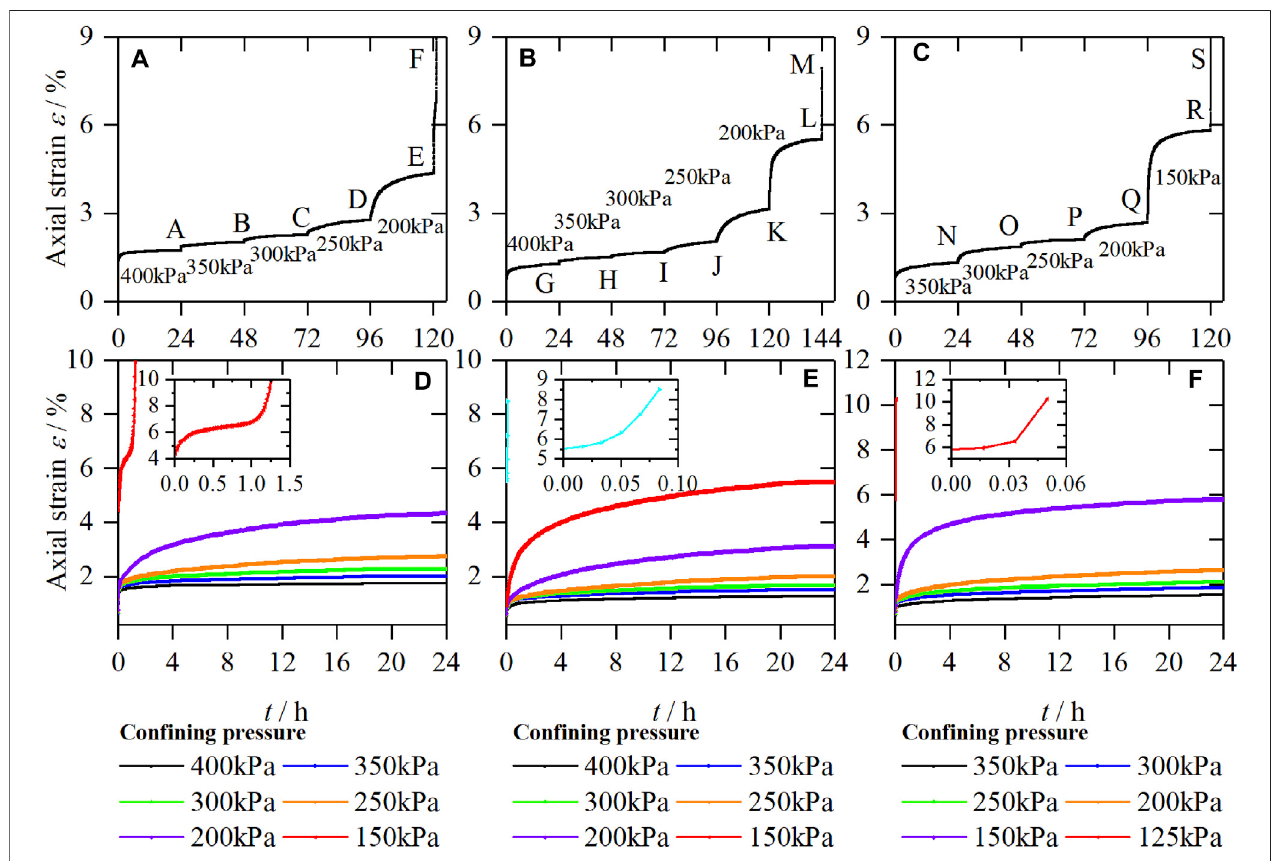
FIGURE 6 | Strain-time curves of samples, (A) UC-4 (B) UC-5, (C) UC-6, and creep curves of samples, (D) UC-4, (E) UC-5, (F) UC-6.